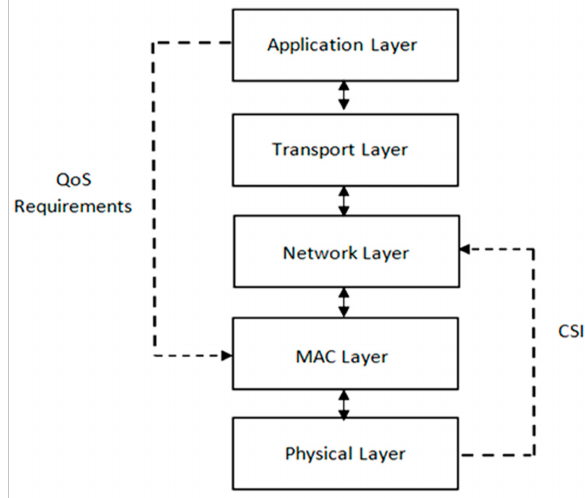
Figure 5. Two examples of cross-layer (CL) interactions in the protocol stack for MANETs (Adapted from